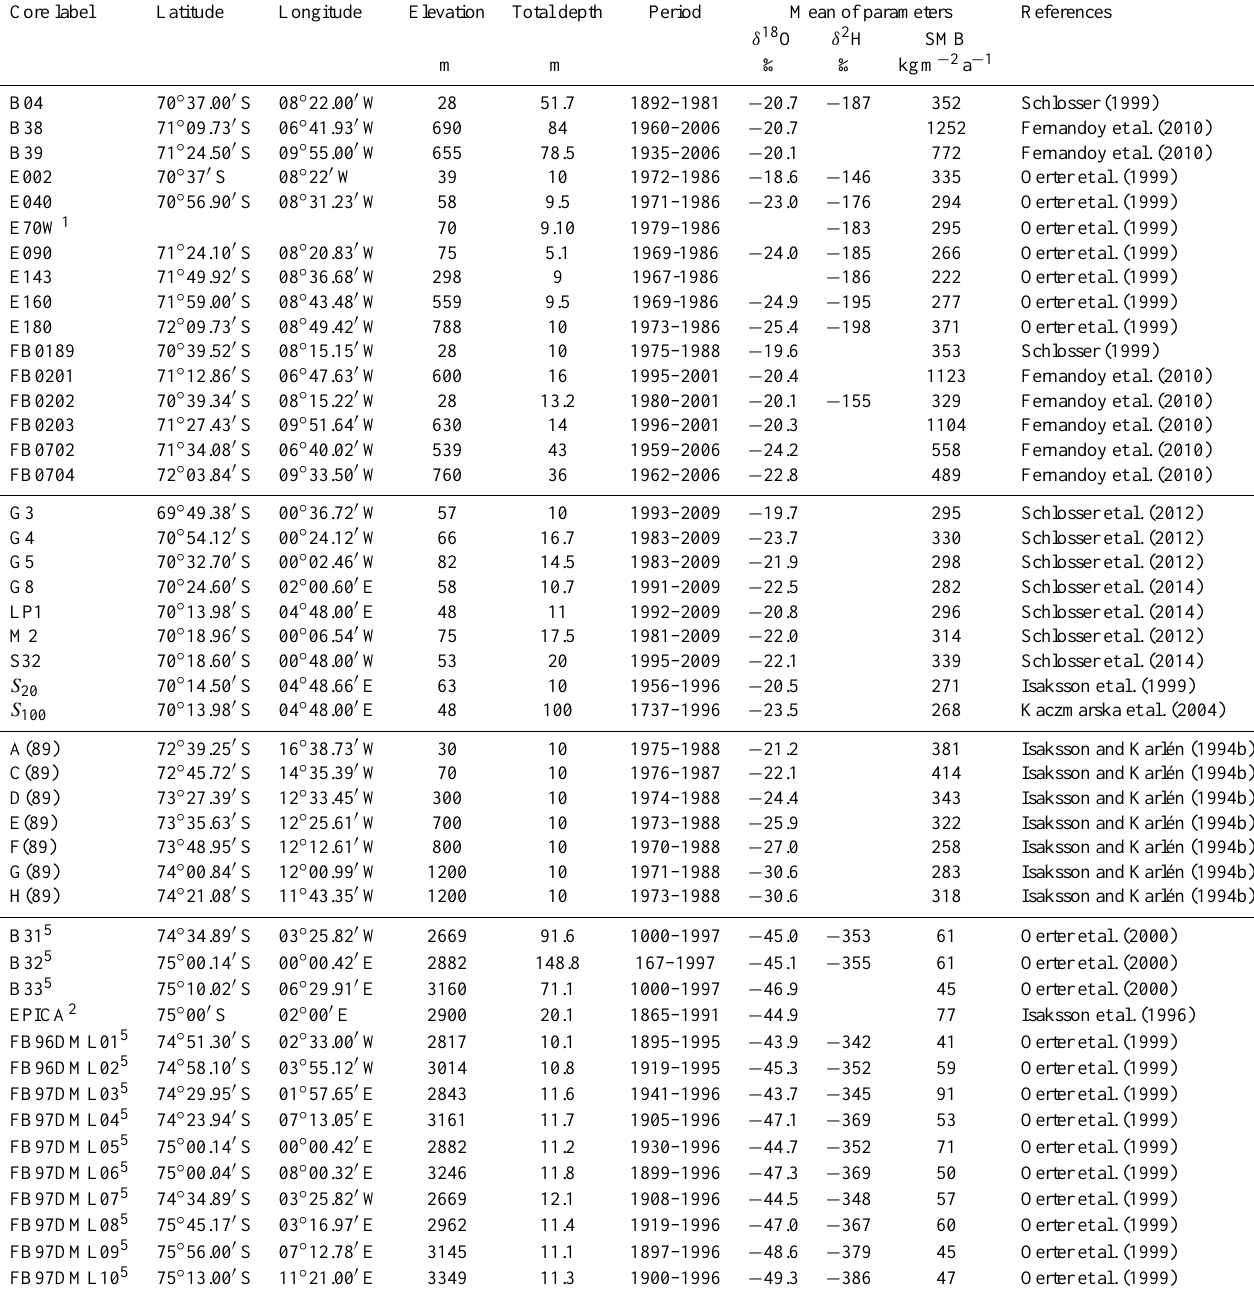
Table A1. Location (latitude, longitude, elevation), total depth, time period and annual mean values of δ 18 O, δ D and SMB for all cores in western Dronning Maud Land (see Fig.